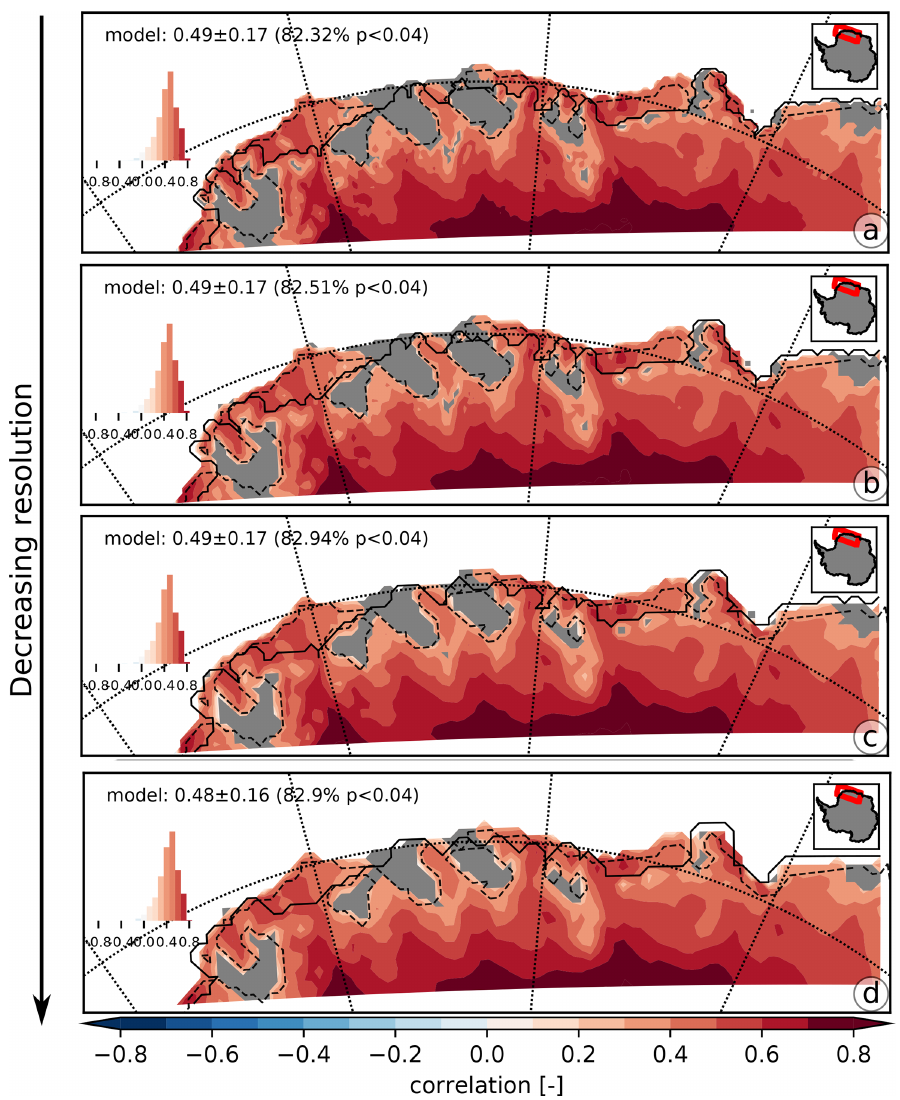
Figure 7. Annual correlation between SMB and SAT for RACMO5 simulations over increasing grid scalings from top to bottom: (a) 11km, (b) 16.5km, (c) 22km, and (d) 27.5km over 1979–2016. Statistically insignificant areas ( p > p FDR , the threshold p value calculated) for each resolution are hashed in grey. A dashed black line outlines the areas with a low SAT–SMB annual correlation from Fig. 1f, for comparison. The histogram displays the distribution of correlation values for each panel. Region-wide annual correlation mean, standard deviation, and percentage of model area with p < p FDR are provided in each